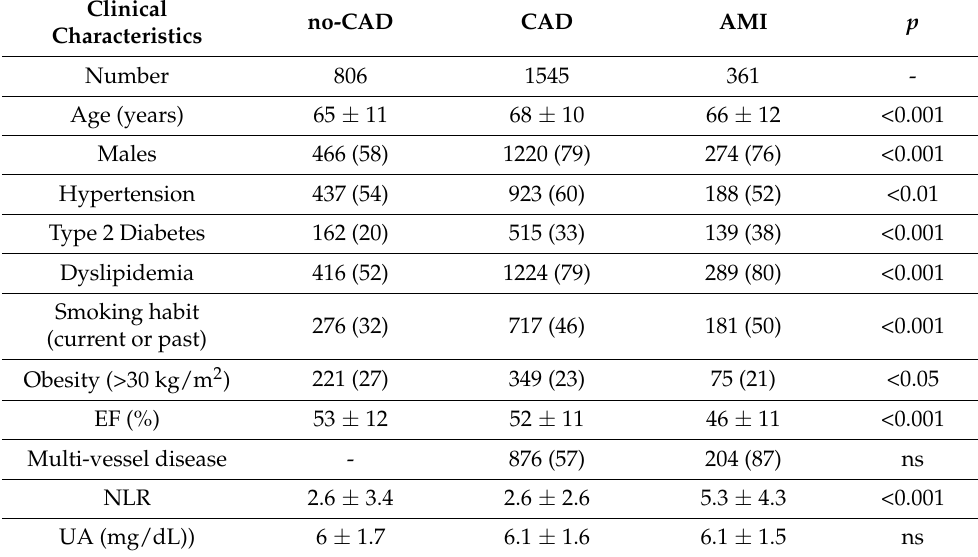
Table 1. Baseline characteristics of the study population.